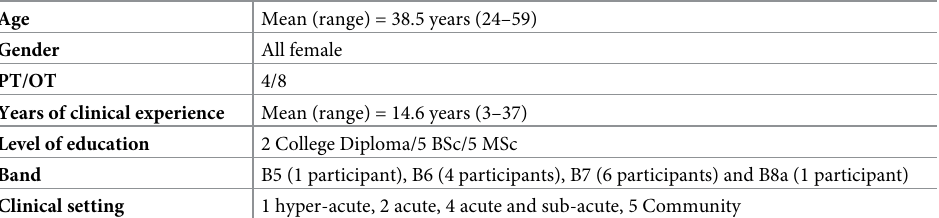
Table 1. Characteristics of participating